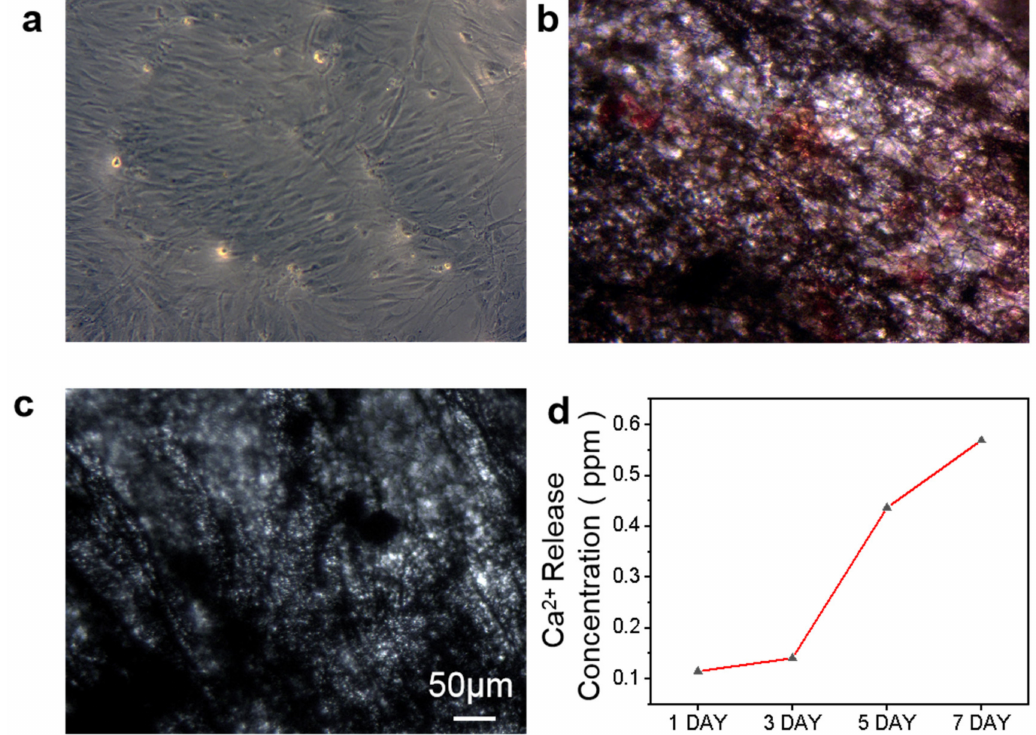
Figure 6. Alizarin Red S staining on day 21 shows osteoblast mineralized calcium nodules in cells grown on ( a ) tissue culture plastic (TCP) and ( b ) 5% HAp/CNF. Panel ( c ) shows staining of 5% HAp/CNF without cells. ( d ) The concentration of Ca 2+ in solution in 7